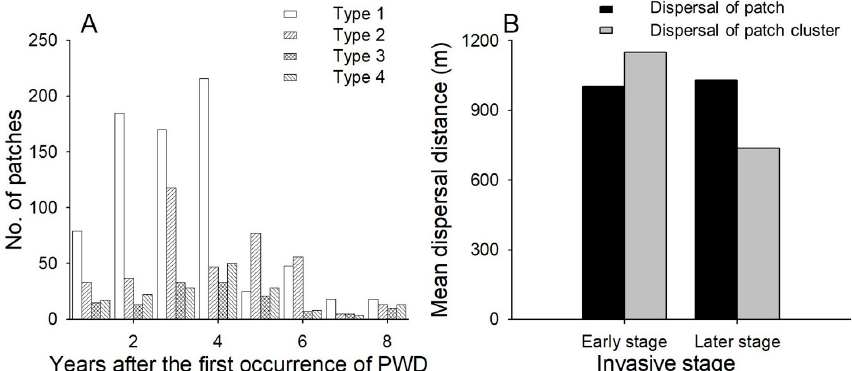
Figure 2. ( A ) Changes in the proportion of dispersal types according to the number of years after the first occurrence of PWD; ( B ) Annual dispersal distance at different invasive stages. Early stage: within four years after the invasion; later stage: more than four years after the invasion. Dispersal distance of a patch was measured as D in Figure